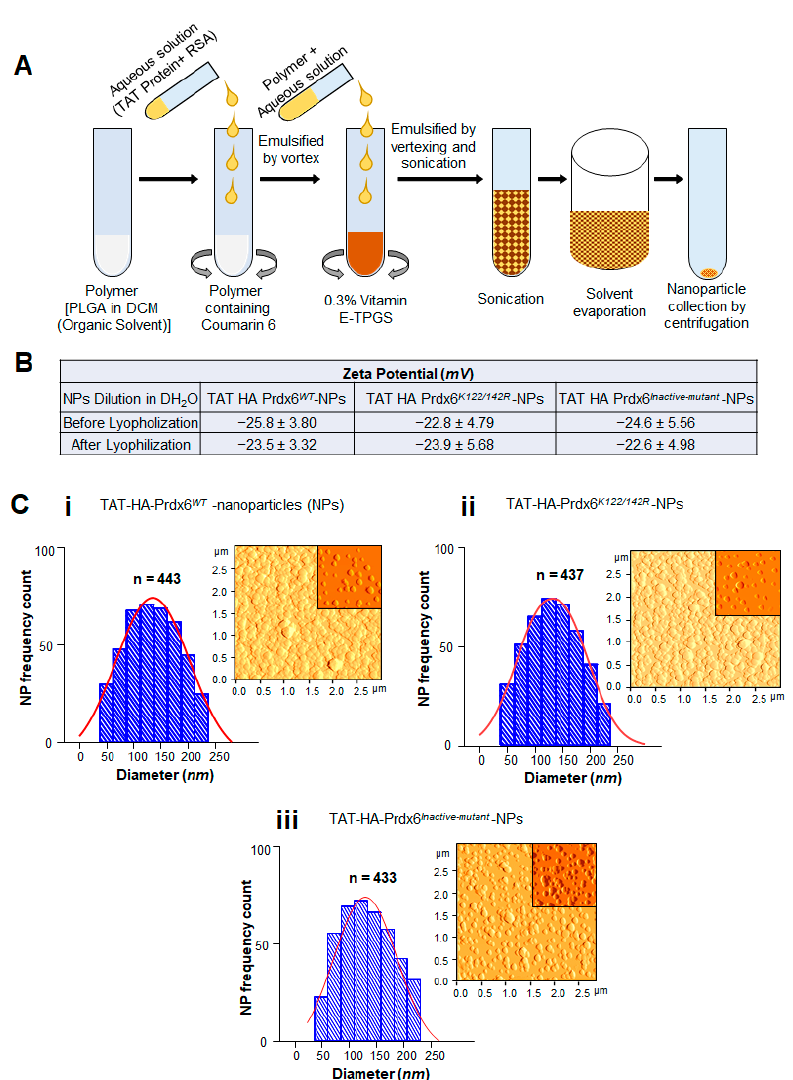
Figure 2. Synthesis and characterization of TAT-HA-Prdx6 WT , TAT-HA-Prdx6 K122/142R , and TAT-HA-Prdx6 Inactive-mutant protein-loaded nanoparticles. ( A ) Schematic representation of TAT-HA-Prdx6 protein analog-loaded nanoparticles made by the emulsion solvent evaporation technique [61,74]. ( B ) Zeta potential of TAT-HA-Prdx6 WT -NPs, TAT-HA-Prdx6 K122/142R -NPs, and TAT- HA-Prdx6 Inactive-mutant -NPs before and after lyophilization. Surface charge (zeta potential) of encap- sulants prepared by mixing 1:50 ratio of TAT-HA-Prdx6 protein analog-NPs with DH 2 O. Standard error (mean ± SD) for n = 3. ( C ) Representation of atomic force microscopy (AFM) images showing homogenous particle distribution. AFM image (inset, image after dilution) and corresponding size (diameter—nm) distributions of TAT-HA-Prdx6 protein analog